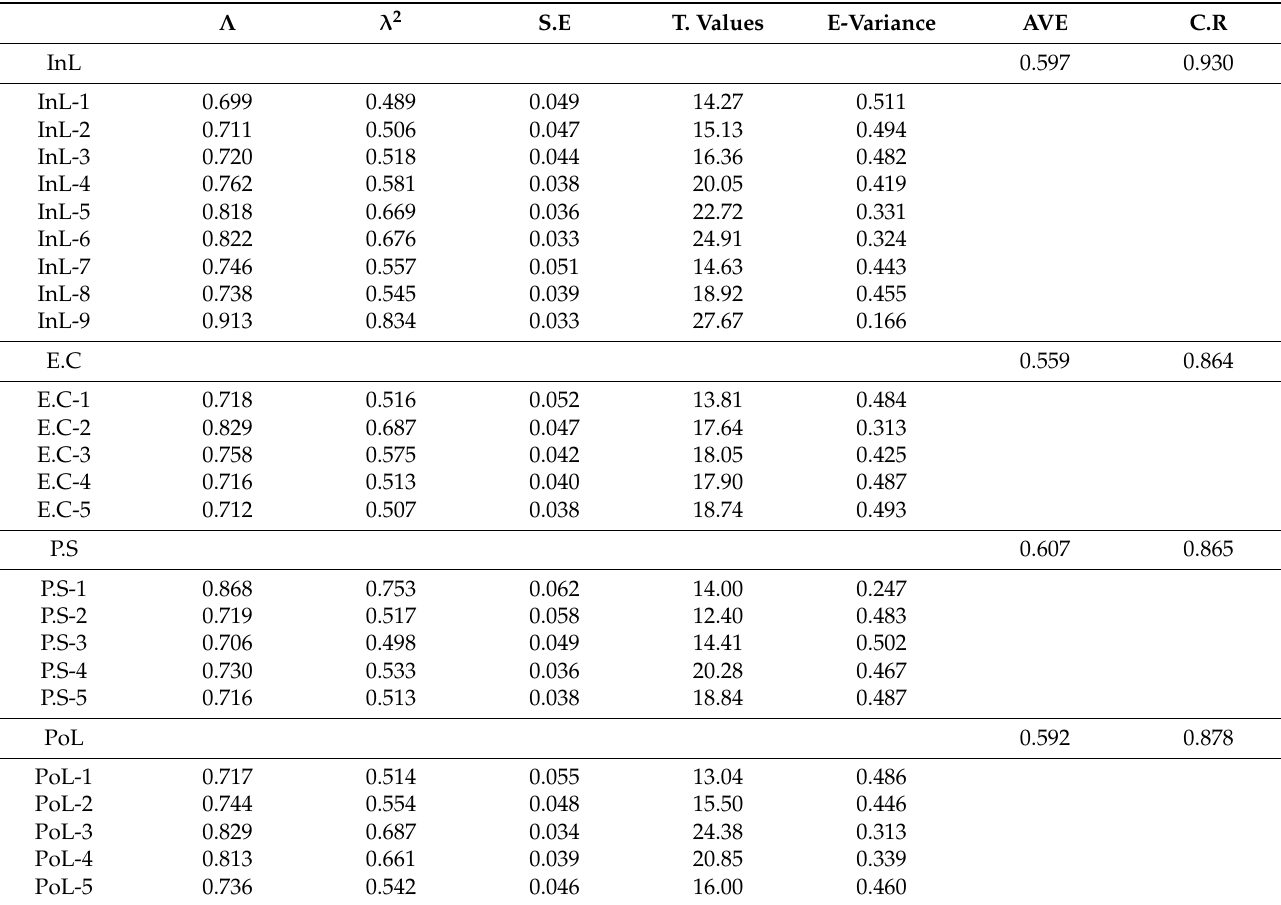
Table 2. Construct